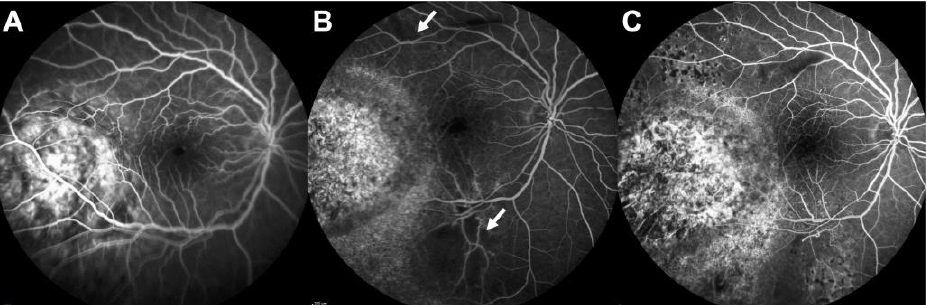
Figure 3. Radiation retinopathy in a patient treated with plaque brachytherapy for choroidal melanoma; ( A ) Fluorescein angiography (FA) at baseline showing the localization of the melanoma close to the macular area; ( B ) FA at 2 years showing 2 retinal ischemic areas (white arrows); ( C ) FA at 3 years showing the enlargement of the foveal avascular zone and the increased surface of ischemic areas. Laser photocoagulation was partially performed.